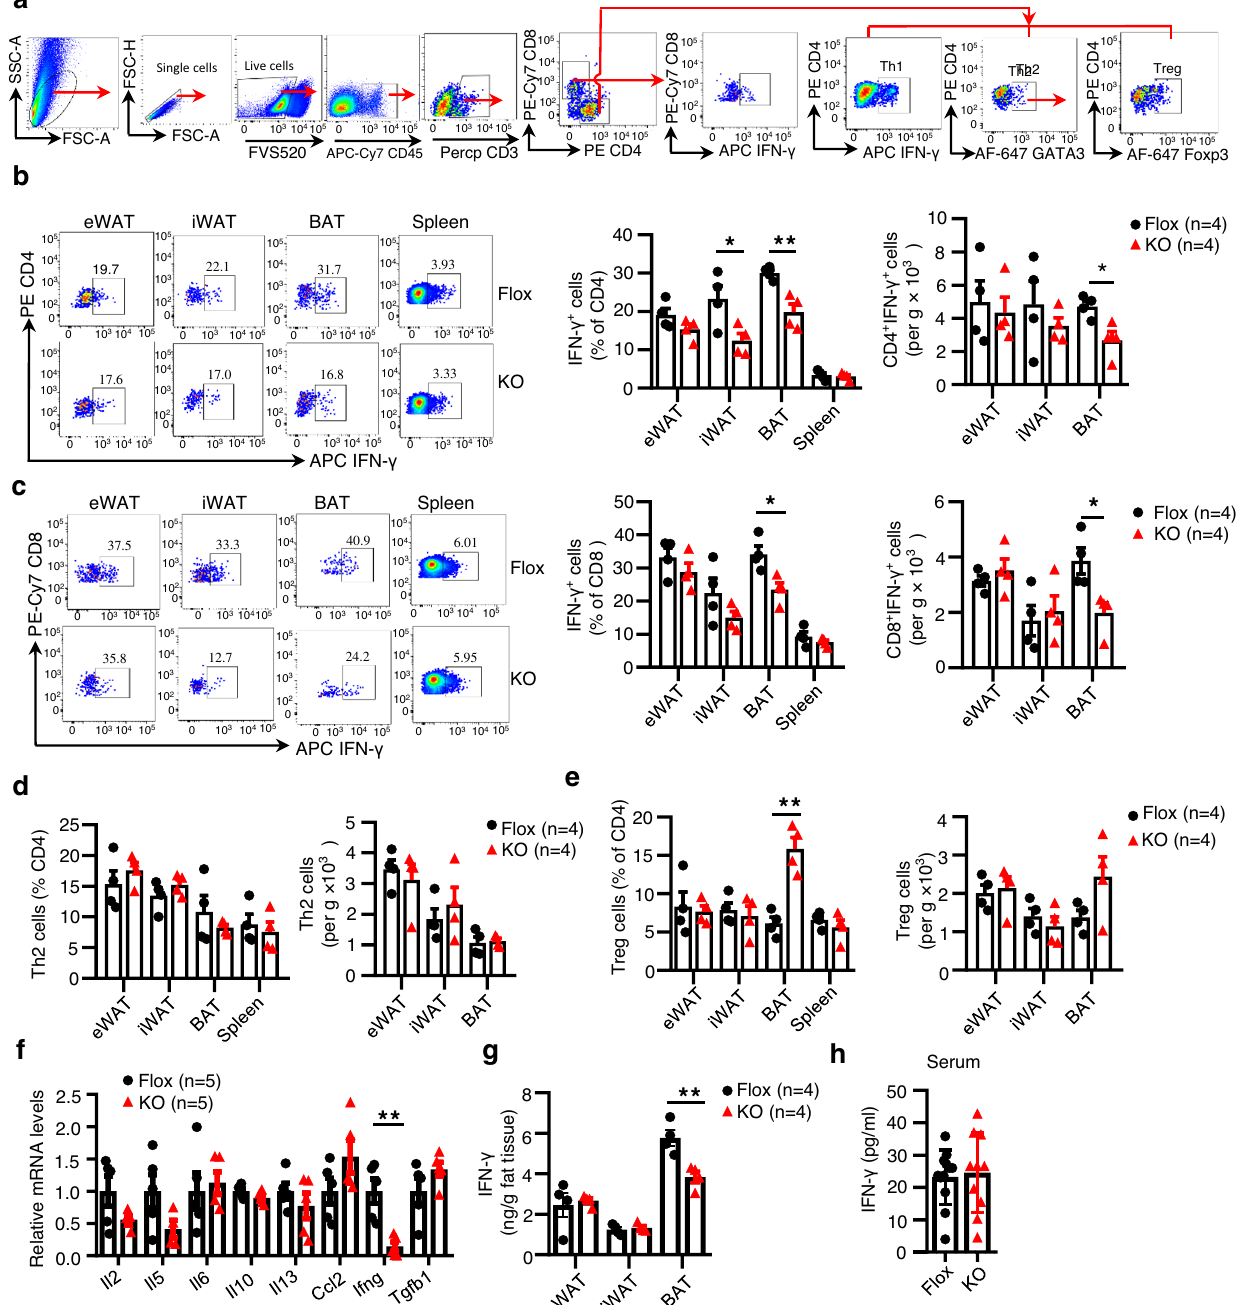
Fig. 5 DsbA-L de fi ciency in T cells suppresses IFN- γ production while promoting Treg cell accumulation. DsbA-L CD4-KO mice and control littermates were fed an HFD for 5 weeks. a Gating strategies of T cell subsets in adipose tissues. b Representative FACS plots of CD4 + IFN- γ + Th1 cells (left panel) and quanti fi cation of the frequencies and total numbers of CD4 + IFN- γ + Th1 cells (right panel). ( n = 4/group). c Representative FACS plots of CD8 + IFN- γ + T cells (left panel) and quanti fi cation of the frequencies and total numbers of CD8 + IFN- γ + T cells (right panel). ( n = 4/group). d , e Quanti fi cation of the frequencies and total numbers of Th2 cells ( d ) and Treg cells ( e ). ( n = 4/group). f mRNA levels of T cell-associated cytokines in the SVF of BAT. ( n = 5/ group). g Protein levels of IFN- γ in the BAT and iWAT. ( n = 4/group). h Protein levels of IFN- γ in the serum of DsbA-L CD4-KO mice ( n = 10) and control littermates ( n = 12). Data shown are representative of three independent experiments. All data are presented as mean ± SEM. Statistical values p < 0.05 (*), p < 0.01 (**), p < 0.001 (***) are determined by two-tailed unpaired Student ’ s t -test. Source data are provided as a Source Data DIT 3 . The expression of tyrosine hydroxylase (TH), a rate- signaling components downstream of β 3AR. Consistent with this, limiting enzyme in the synthesis of catecholamines, and β 3AR in IFN- γ treatment signi fi cantly suppressed the β 3AR agonist BAT were similar between DsbA-L CD4-KO mice and control CL316,243-induced thermogenic gene expression in primary littermates after HFD feeding for 5 weeks (Fig. 6d), suggesting brown adipocytes (Fig. 6e). Based on the fi nding that PKA that DsbA-L in T cells may regulate thermogenesis by targeting activation is critical for UCP1 expression in BAT 27 , we checked